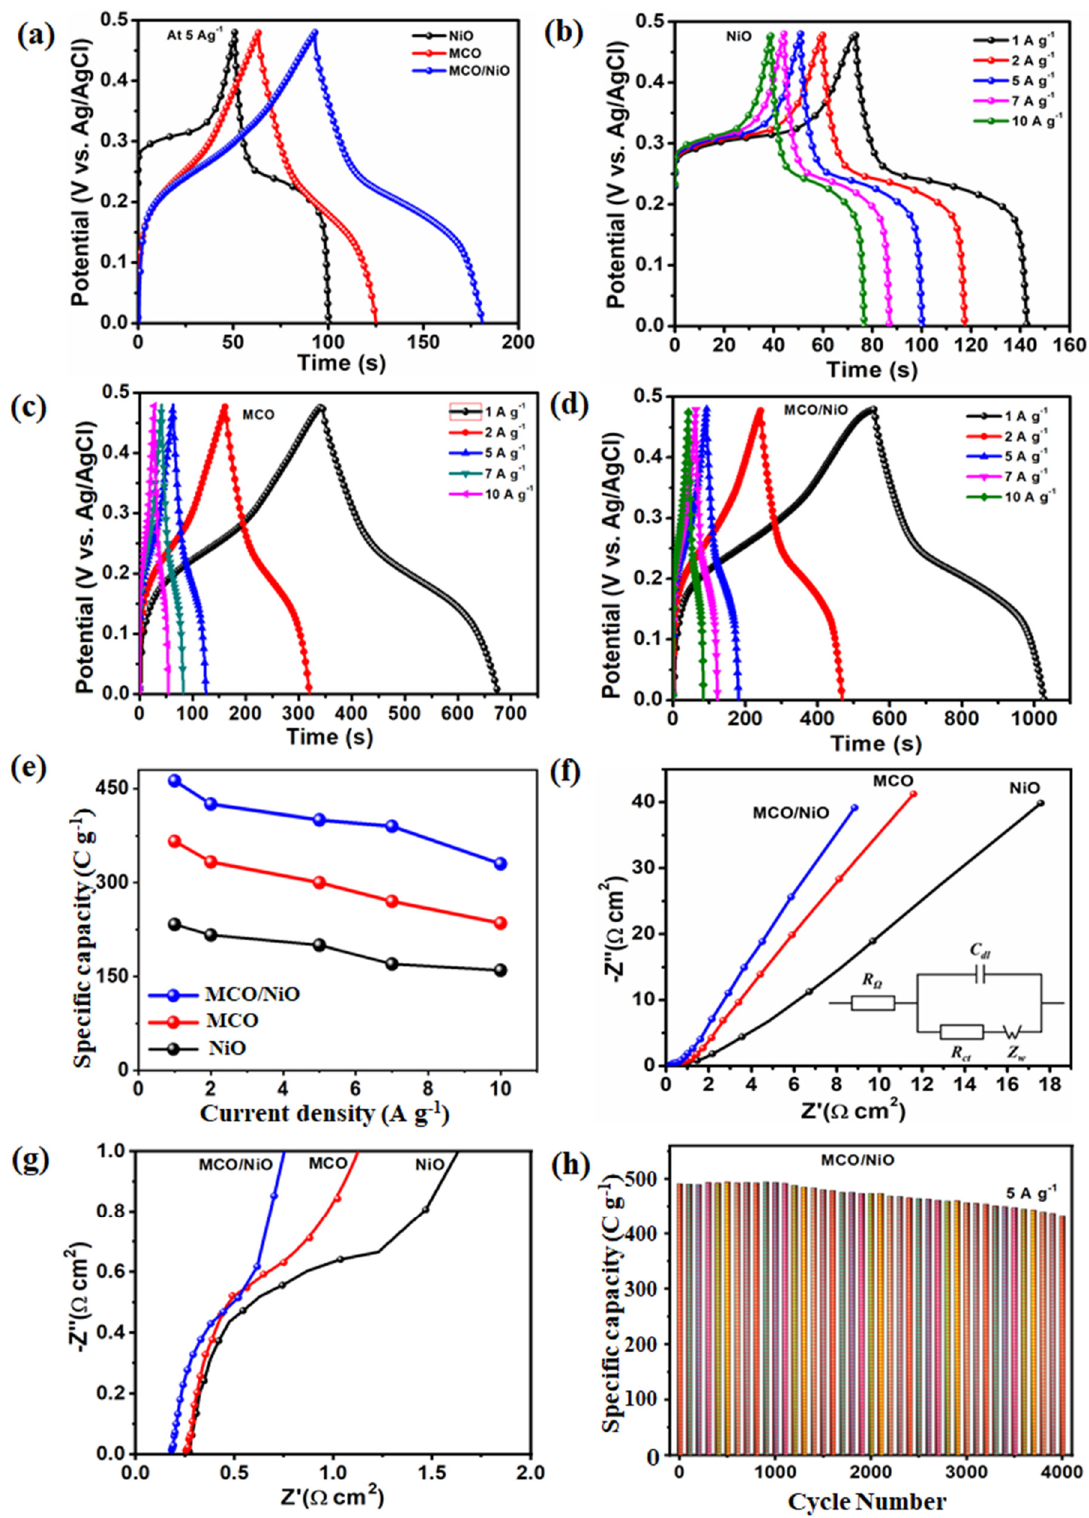
Figure 5. ( a ) Comparison of GCD plots for MCO, NiO, and MCO/NiO at 1 Ag − 1 , GCD plots of ( b ) NiO, ( c ) MCO, and ( d ) MCO/NiO at various current densities and ( e ) specific capacity values of MCO, NiO, and MCO/NiO electrodes with respect to current density. ( f ) EIS of MCO, NiO and MCO/NiO electrodes. ( g ) The magnified view of the Nyquist curve of MCO/NiO electrode. ( h ) Cycling stability of the MCO/NiO electrode. the magnified view of the Nyquist curves.